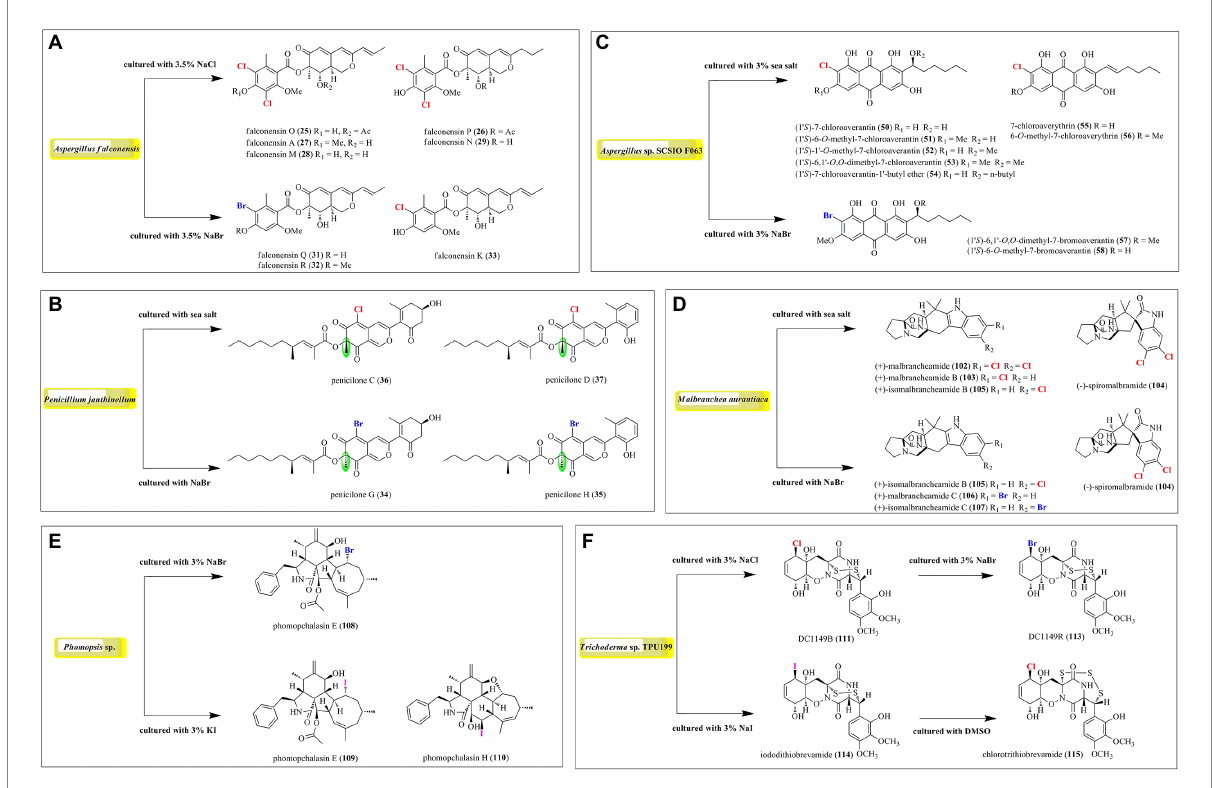
FIGURE 9 Induced production of halometabolites with different cultural conditions. (A) Azaphilones produced by Aspergillus falconensis; (B) Azaphilones produced by Penicillium janthinellum; (C) Anthraquinones produced by Aspergillus sp. SCSIO F063; (D) Prenylated indole alkaloids produced by Malbranchea aurantiaca; (E) Cytochalasin produced by Phomopsis sp. QYM-13; (F) Epipolythiodiketopiperazines produced by Trichoderma sp.